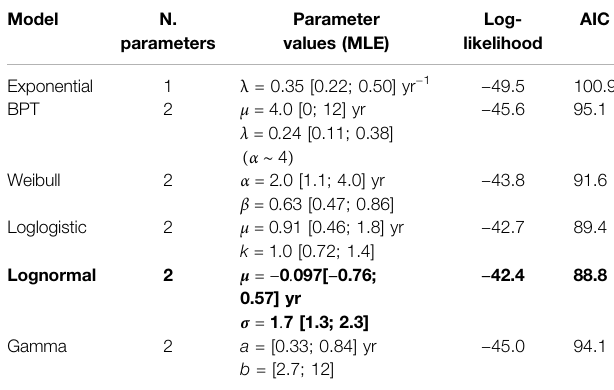
TABLE 4 | Competing models tested for describing the intra-cluster time intervals (long term process) considering the 6-clusters partition %. Model N. Parameter Log- likelihood parameters values (MLE) likelihood